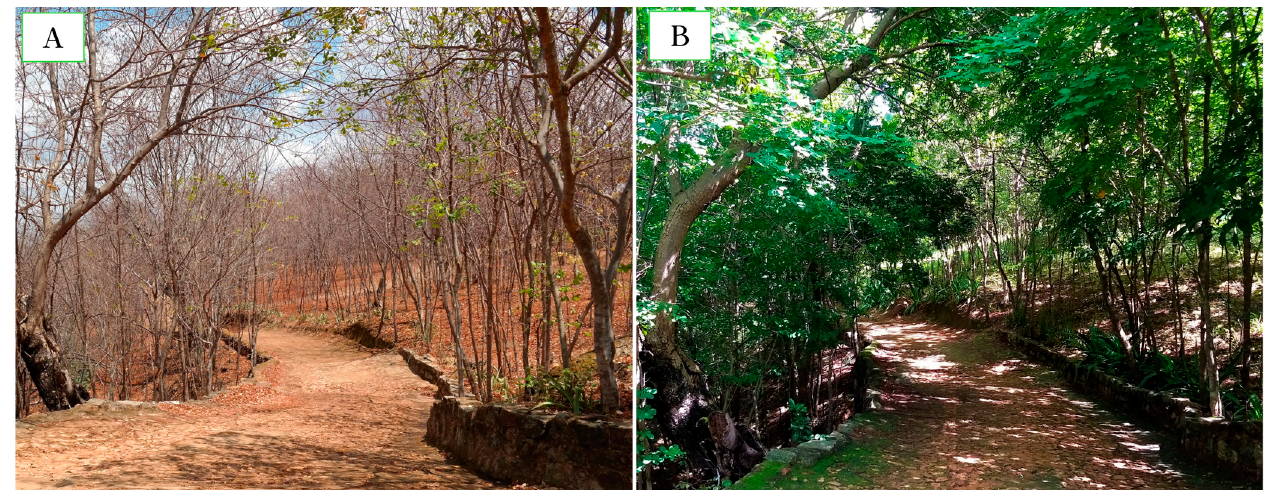
Figure 8. Entrance stretch Santo Sepulcro trail, “Green Tunnel” caatinga vegetation in the dry ( A ) and rainy ( B ) season; Colina do Horto Geosite, Araripe UGG. Source: Research Collection.